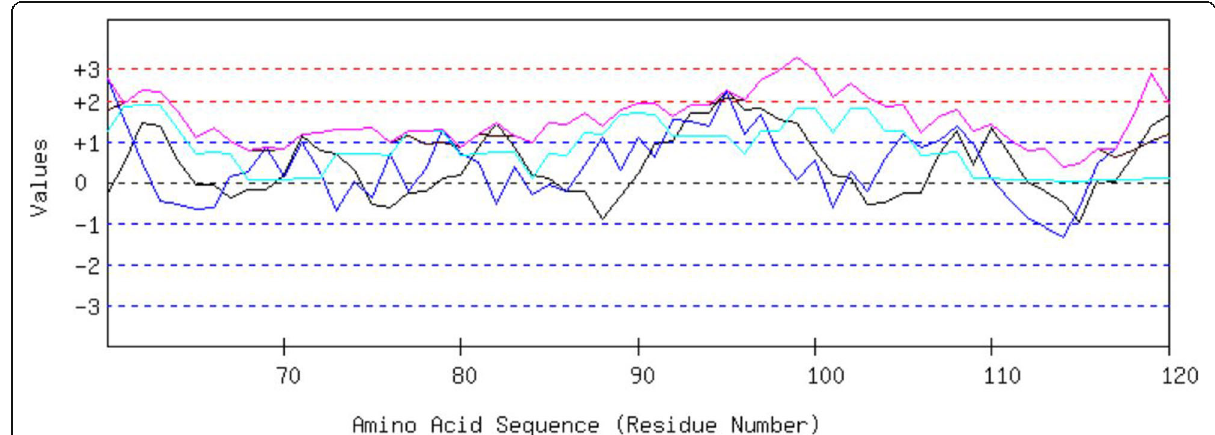
Fig. 1 The graphical output format of the prediction of B-cell epitope by BCPred, which is a plot of the epitope values against the residue number. The graph uses a scale which is normalized between + 3 and − 3, with high values giving rise to the peaks. The different colors of the peak lines denote the individual physiochemical properties in which the prediction was based on. The blue, black, cyan, and purple colored peak lines as shown in the figure denote the flexibility, hydrophilicity, polarity, and combined physiochemical properties respectively